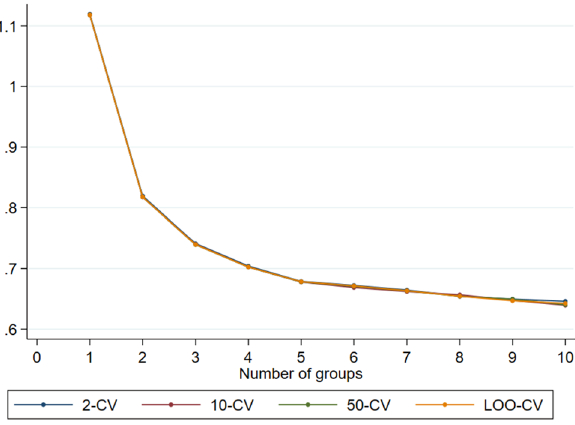
Figure 1. Estimated mean distance for 2-CV, 10-CV, and 50-CV over number of